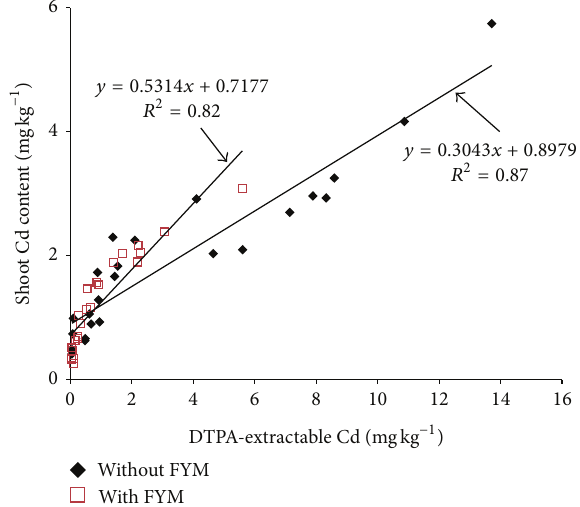
Figure 2: Relationship between shoot Cd concentrations and soil DTPA-extractable